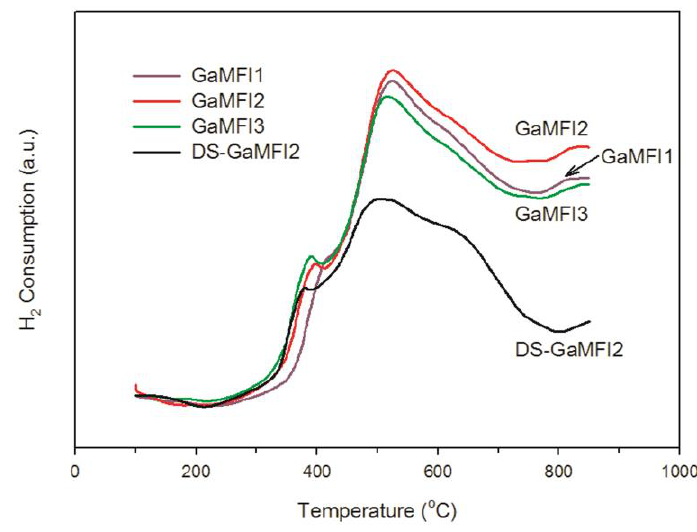
Figure 2. H 2 -TPR profiles of Ga-containing MFI zeolites.